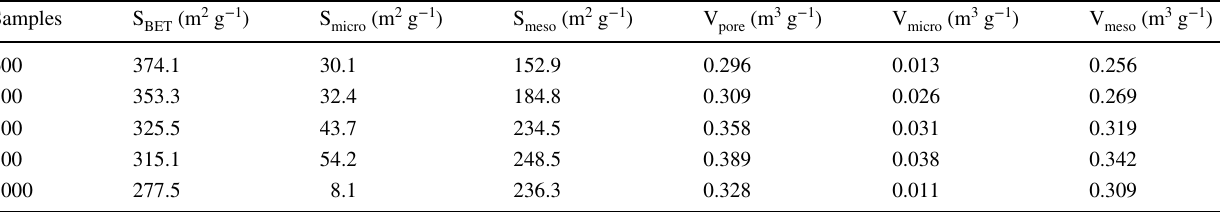
Table 2 Surface area and pore structure of PTC composites annealed at different temperatures